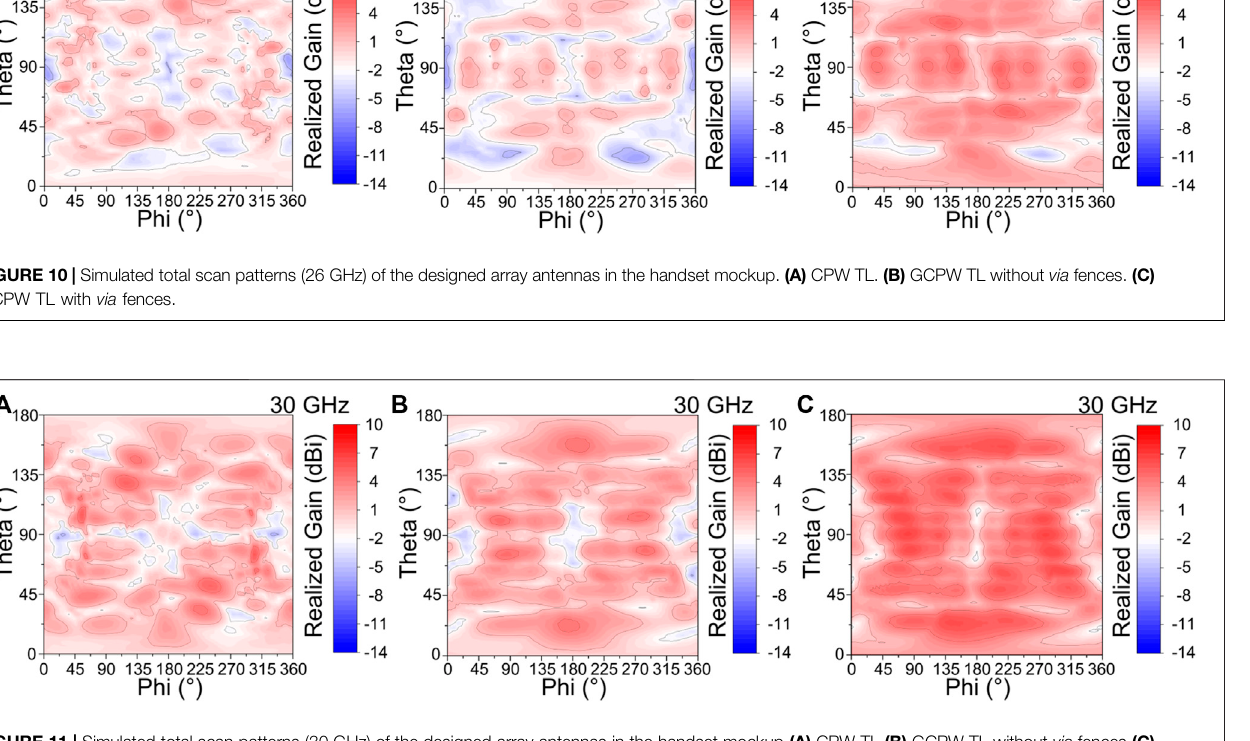
Frontiers in Communications and Networks |